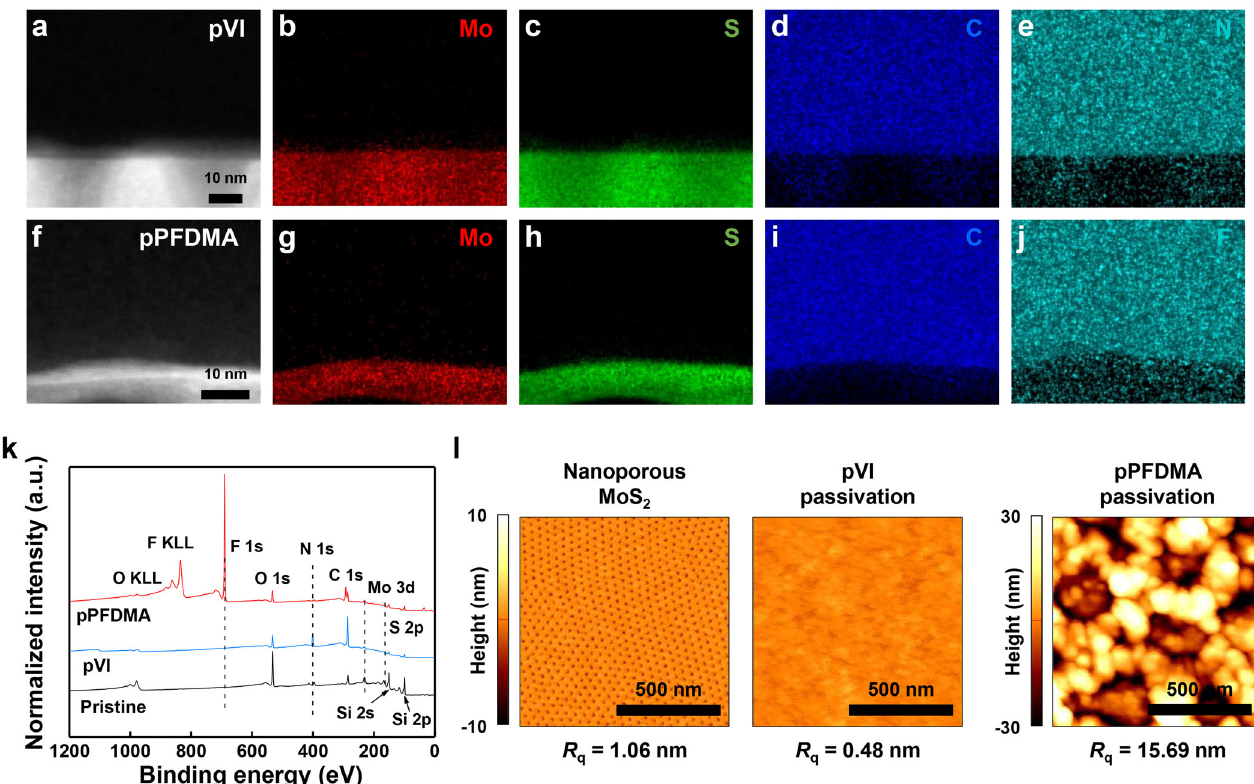
Fig. 3 Chemical and morphological properties of polymer-passivated nanoporous MoS 2 fi lms. HAADF-STEM images and EDS elemental mapping of the a-e pVI- and f-j pPFDMA-passivated nanoporous MoS 2 . False color modi fi cation was attempted in EDS elemental mapping images to clearly reveal the polymeric passivation layers and nanoporous MoS 2 . k XPS survey scan spectra of the pristine and polymer- passivated nanoporous